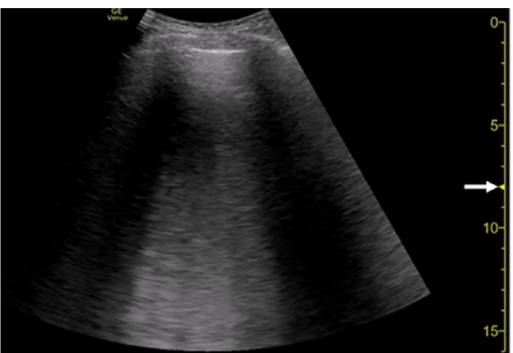
Figure 9. Ultrasound image obtained by Venue scanner (GE Healthcare) with a curvilinear transducer in the same case as Figure 5. As the single focal point (arrow) is shifted to a deeper level, each B-line becomes wider and overlaps each other.